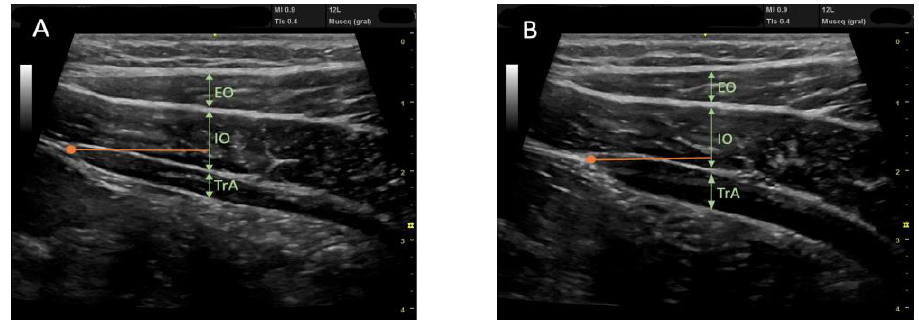
Figure 2. Ultrasound images of the lateral abdominal wall musculature showing the 3 muscle layers from top to bottom: External Oblique (EO), Internal Oblique (IO), and the deepest, Transverse Abdomen (TrA); separated from each other by intermuscular connective tissue (hyperechoic lines). ( A ) Image at rest. ( B ) An image taken during muscle activity showing a change in muscle thickness. Measurements are always taken at the same point, 2 cm (the orange mark) from the insertion of the TrA in the RA.